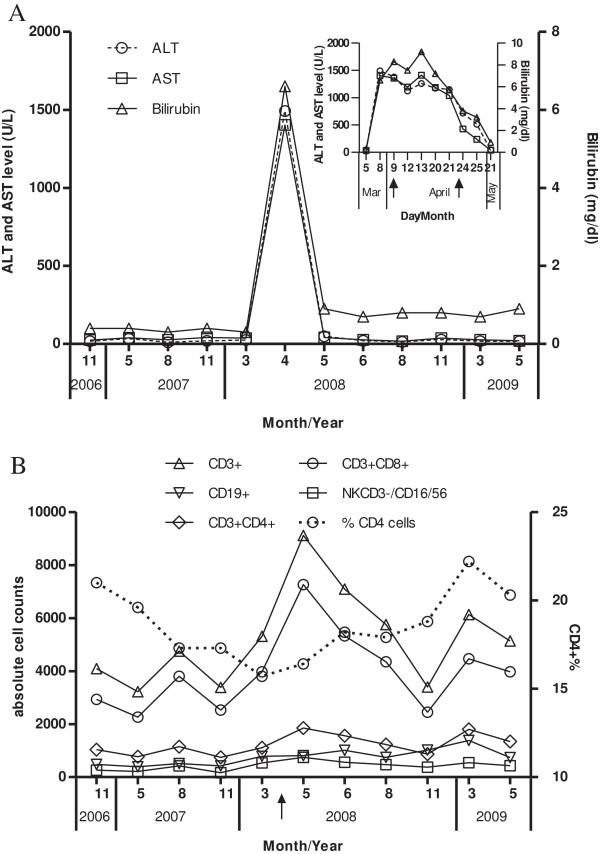
The ALT, AST, bilirubin levels and lymphocytes counts in an HBV/HIV coinfected patient experiencing a spontaneous HBV reactivation. (A) The ALT, AST and bilirubin levels were monitored regularly from 2006 to 2009. The ALT and AST levels were plotted at the left Y-axis and the bilirubin level at the right Y-axis. The insert indicated the ALT, AST and bilirubin levels during the flare-up phase, the black arrows indicated the sampling time for sequencing. (B) The lymphocytes counts were monitored regularly from 2006 to 2009. The relative CD4+ T cell counts in the CD3+ T cell population (CD4 +%) was set at the right Y-axis. The black arrow indicated the start of the antiviral therapy.